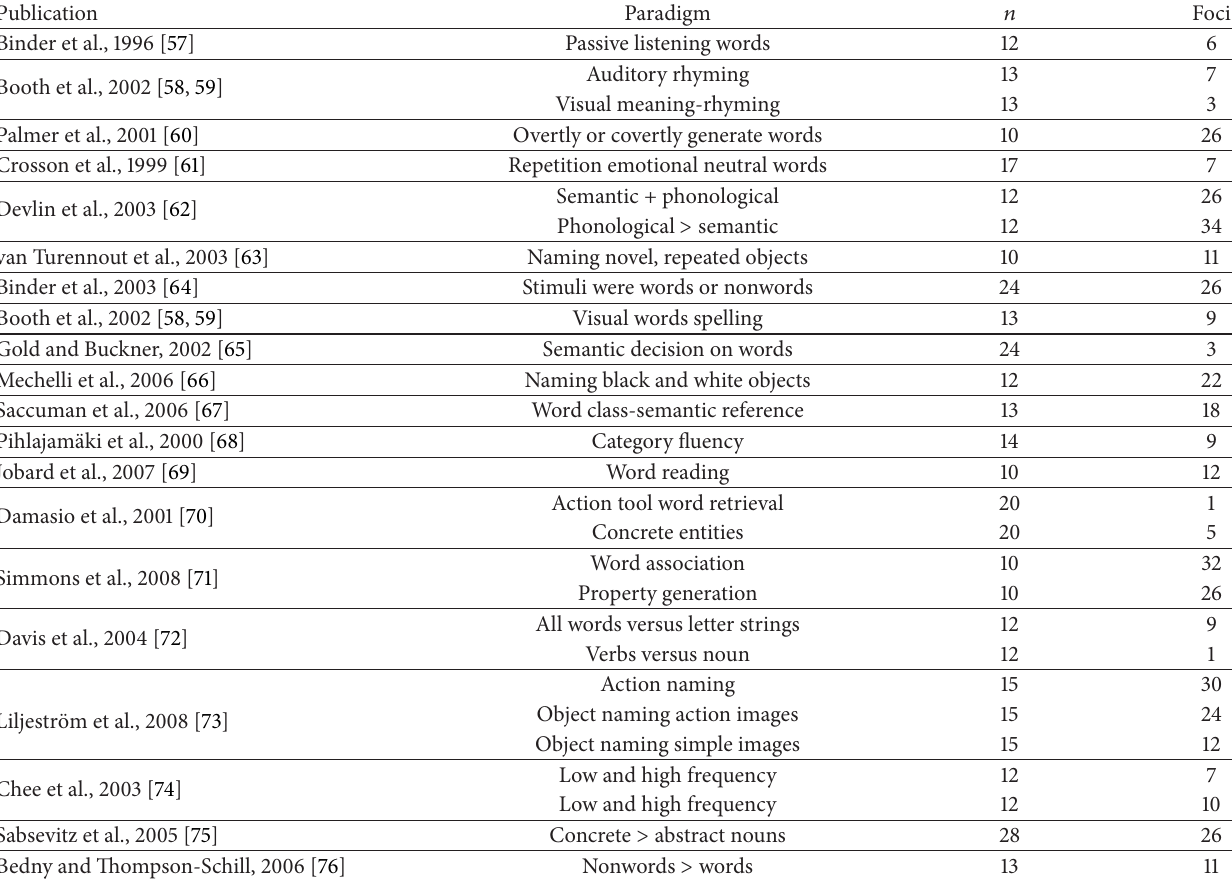
Table 1: Primary studies of language-related paradigms included in the first meta-analysis.